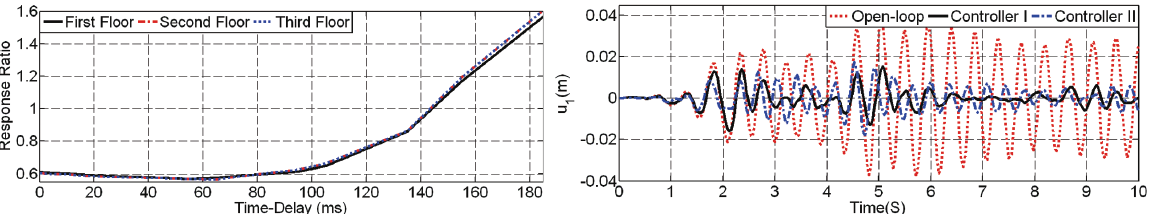
Fig. 10. Maximum response ratio x i max ( τ ) /x i max (0) vs time de- lay τ .